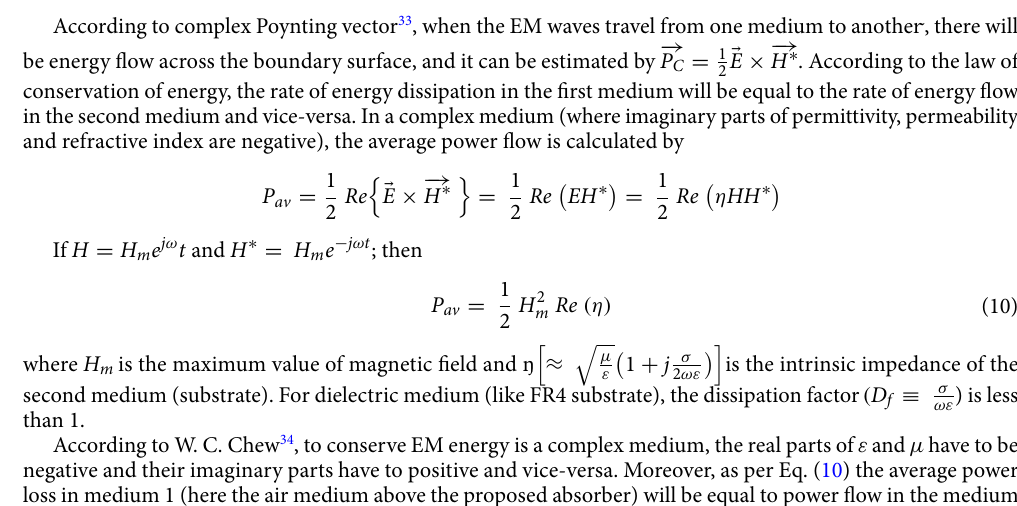
Figure 10. Absorption performance of the unit cell for ( a ) normal incidence and ( b ) oblique